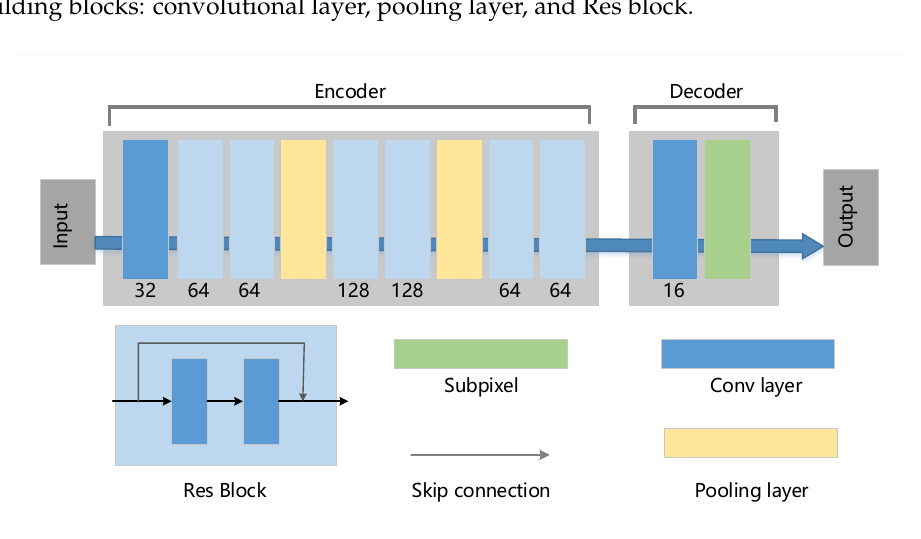
Figure 3. Architecture of Single Scale